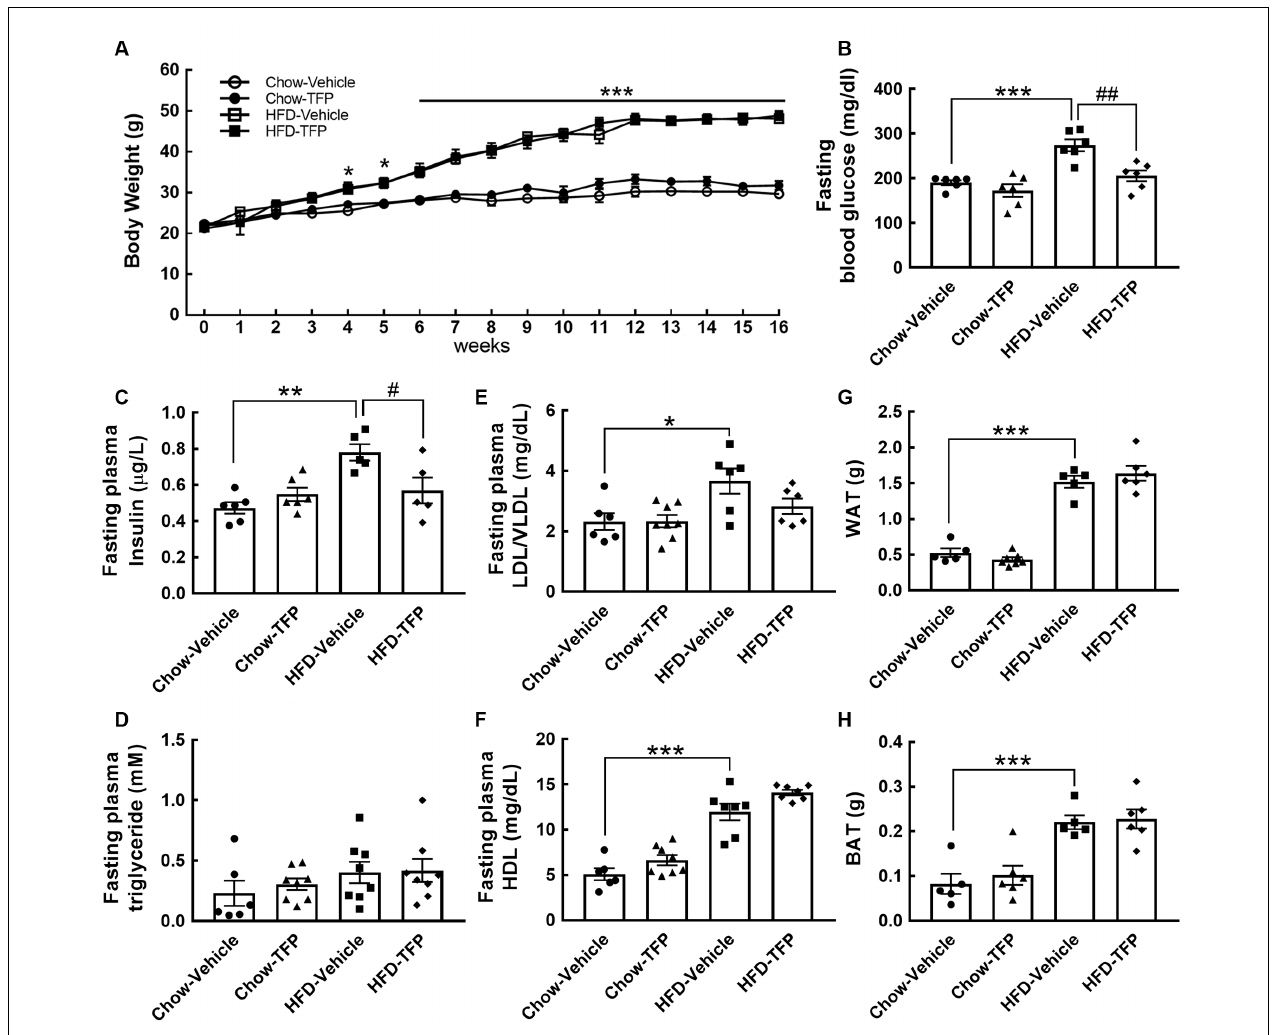
FIGURE 5 | A rise in blood glucose and insulin by chronic HFD feeding was significantly suppressed by treatment with TFP for 4 weeks. (A) The body weights of the four animal groups were measured weekly. The body weight gain was significantly greater in HFD-fed animals treated with vehicle or TFP than in chow-fed animals treated with vehicle or TFP. Data are presented as the mean ± SEM ( n = 6, Chow-Vehicle; n = 8, Chow-TFP, HFD-Vehicle, or HFD-TFP). * p < 0.05, *** p < 0.001 vs. chow-vehicle. (B–H) At 16 weeks post feeding, the animals were made to fast for 15 h, and then blood samples were collected as described in the “Materials and Methods” section. The samples were subjected to a series of assays including blood glucose (B) , insulin (C) , triglyceride (D) , LDL/VLDL (E) , and HDL (F) . In addition, WAT (G) and BAT (H) from the indicated sites in the “Materials and Methods” section were weighed. The results are presented in B-H as the mean ± SEM ( n = 6–8 animals for each group). Each dot represents one animal. * p < 0.05, ** p < 0.01, *** p < 0.001 vs. Chow-Vehicle; # p < 0.05, ## p < 0.01 vs.